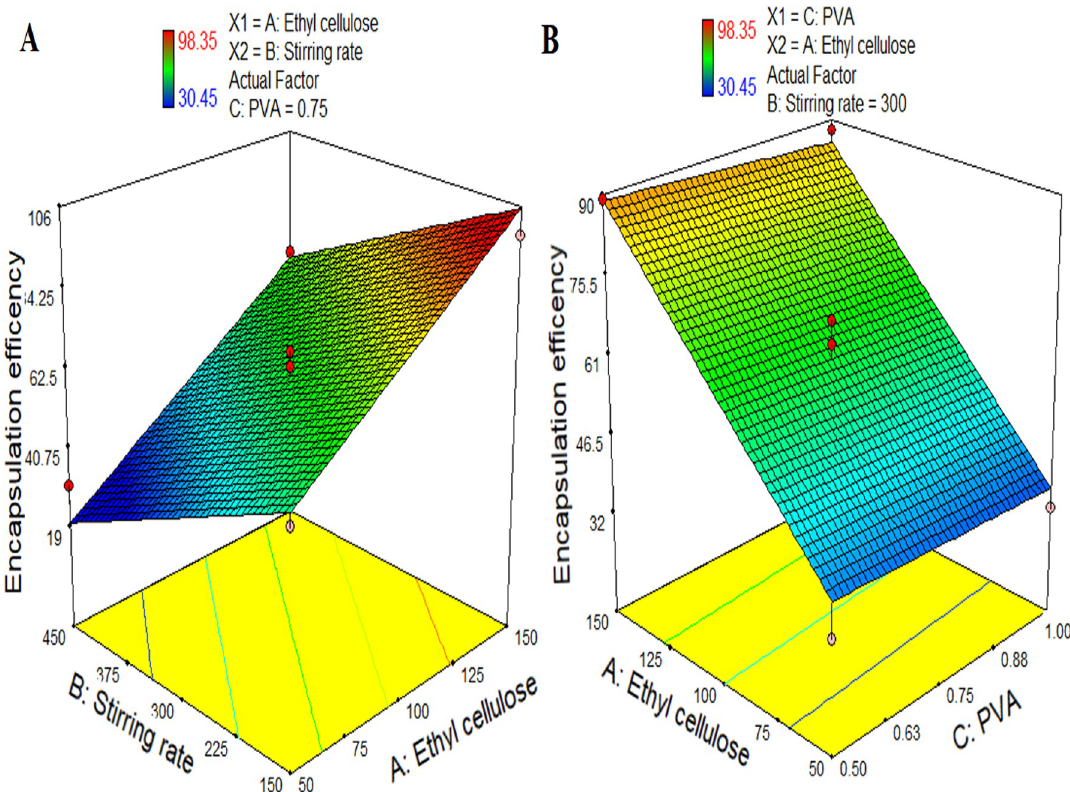
Fig 2. 3-dimensional response surface graphs indicating (A) the effect of the concentration of polymer and stirring speed on EE, and (B) the effect of the surfactant (PVA) and polymer concentration on